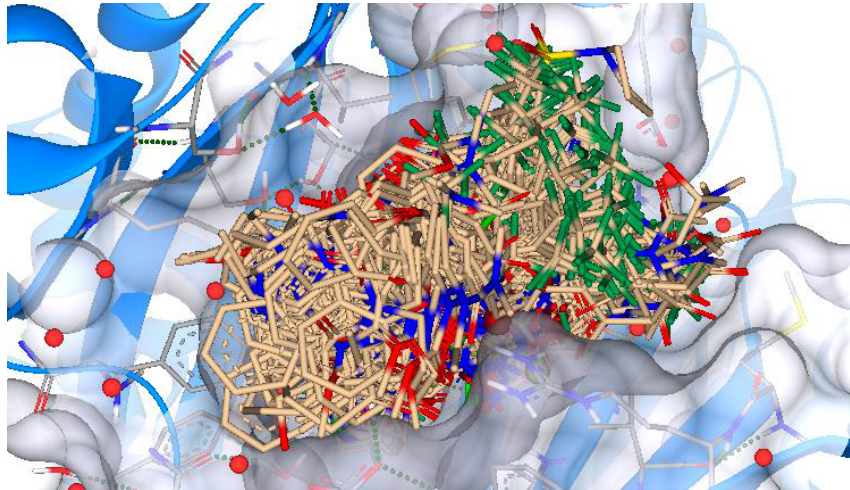
Figure 6. Molecular docking results. The image visualizes all the 540 poses generated from the docking of 54 compounds that were generated by Inspirator mode of SeeSAR based on the nitisinone nucleus.